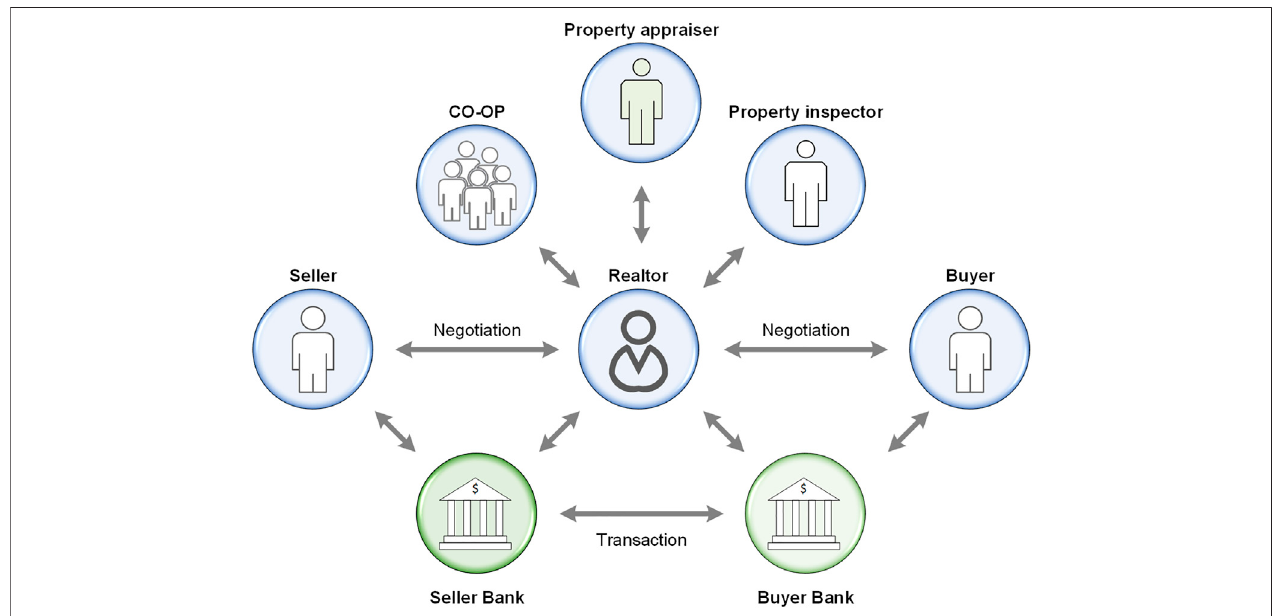
FIGURE 8 | The Real Estate ecosystem